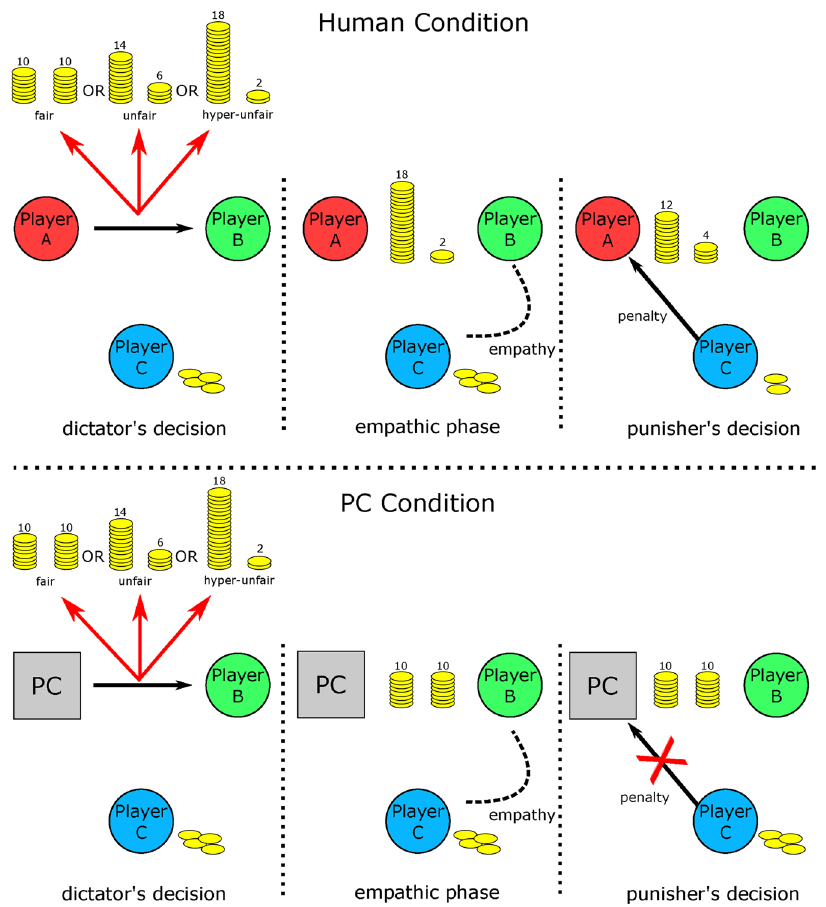
Figure 1. Schematic of TPP game. TPP involves three subjects: player A (the dictator), player B (the receiver), and player C (the observer, who in turn can act as a punisher). Player A has an initial endowment of 20 points, which he can share with player B, selecting among three conditions: fair (10 for A and 10 for B), unfair (14 for A and 6 for B), and hyperunfair (18 for A and 2 for B). Player A’s decision is shown simultaneously to all players (empathic phase). Player C observes the dictator’s decision and can use part, or all, of his endowment (4 points) to punish Player A’s behavior. For every punishment point invested by Player C, 3 points are subtracted from Player A’s payoff, and 1 point is added to Player B’s